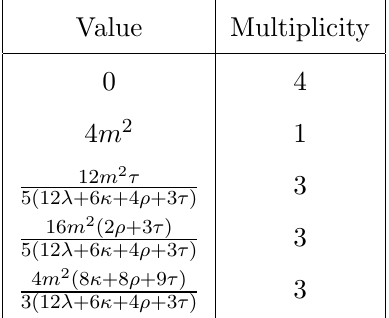
Table 5 . Scalar mass eigenstates for the SSB pattern SU(2) ! T 0 using a complex 7 of